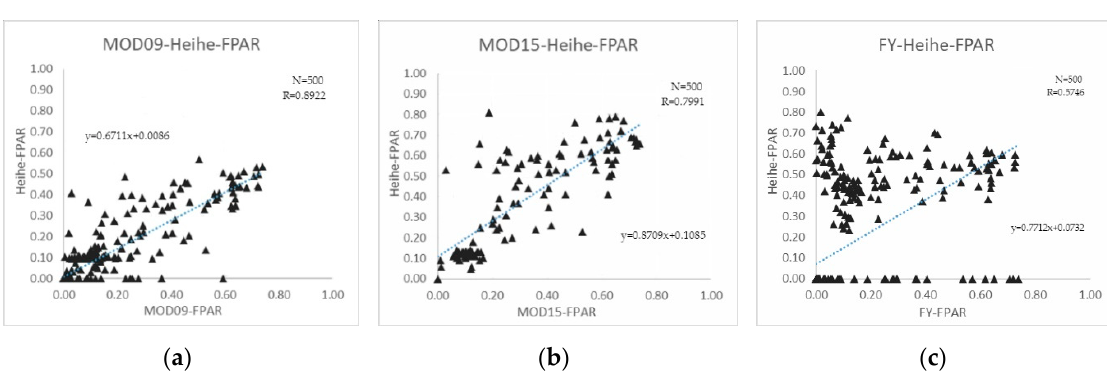
Figure 4. The scatter plots for the FPAR of the validation date. The horizontal axis is the Heihe-FPAR product; the vertical axes in ( a – c ) are the inversions of the FPARs from the MOD09 and FY-3C data and the MODIS FPAR product, respectively.